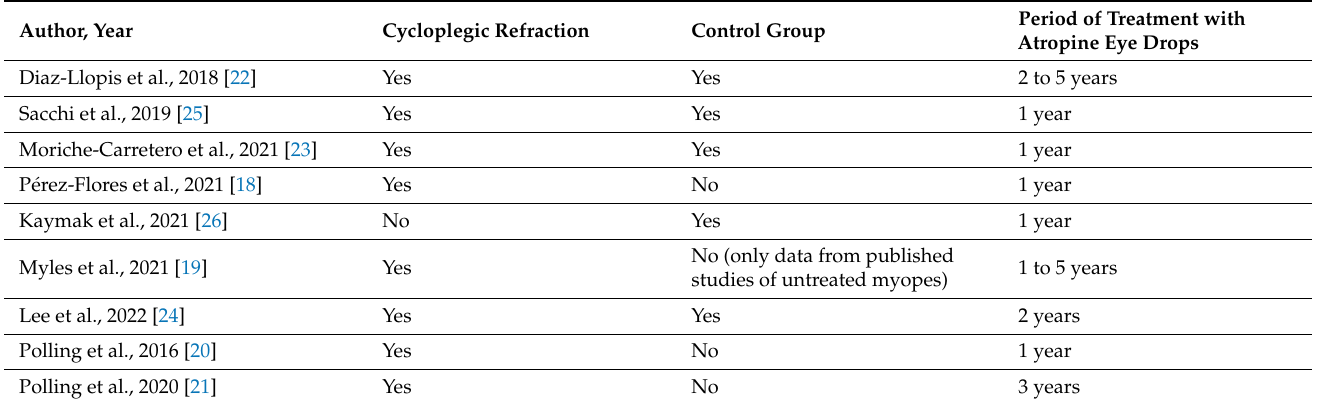
Table 5. Comparison between the studies included in the